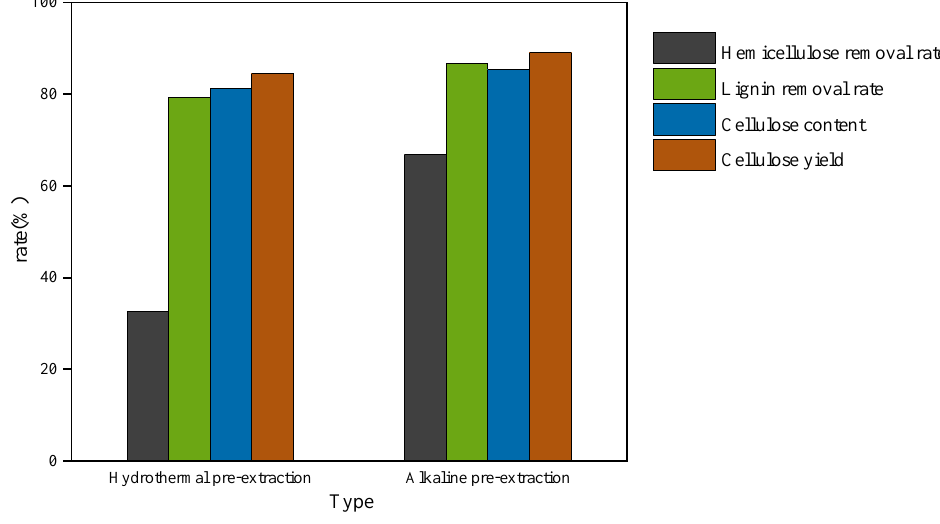
Figure 3. Effect of hydrothermal or alkaline pretreatment on the removal rate of lignin and hemicel- lulose, cellulose content and yield.